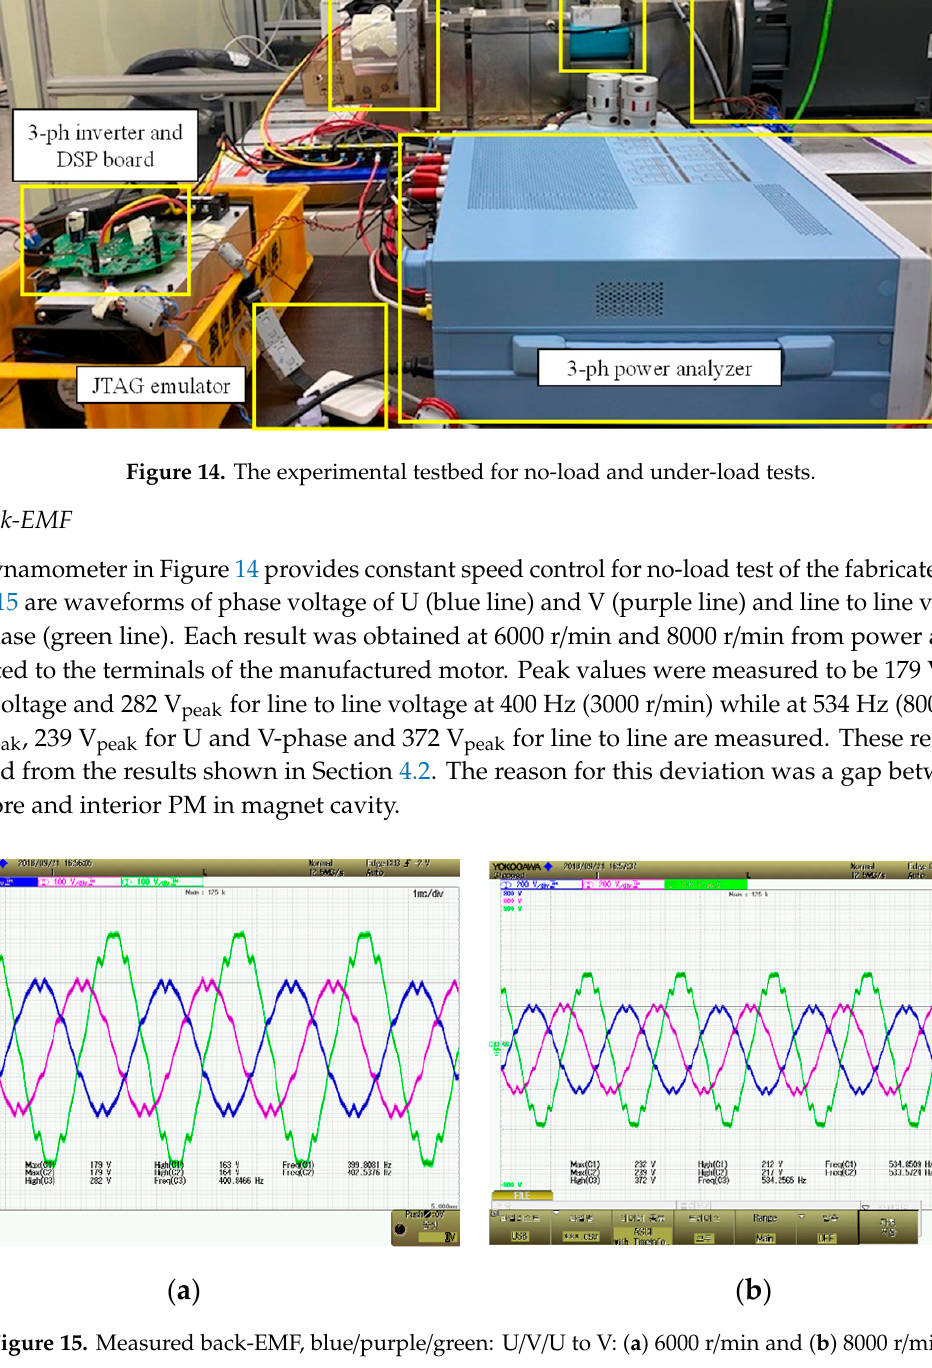
12 of 16 Figure 13. Stator and rotor manufactured for experiments.